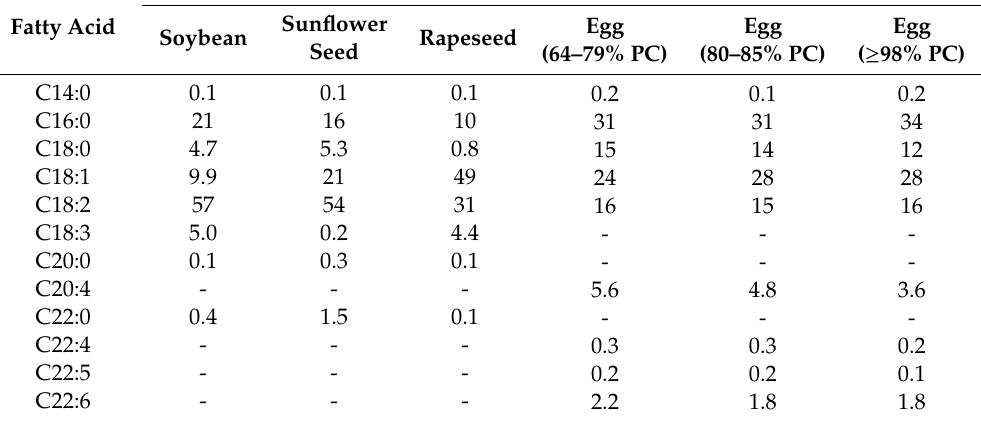
Table 2. Fatty acid composition of vegetable de-oiled lecithins (derived from product specifications [16]) and egg phospholipids of di ff erent PC contents (after extraction and chromatography [17]), respectively. Data taken from